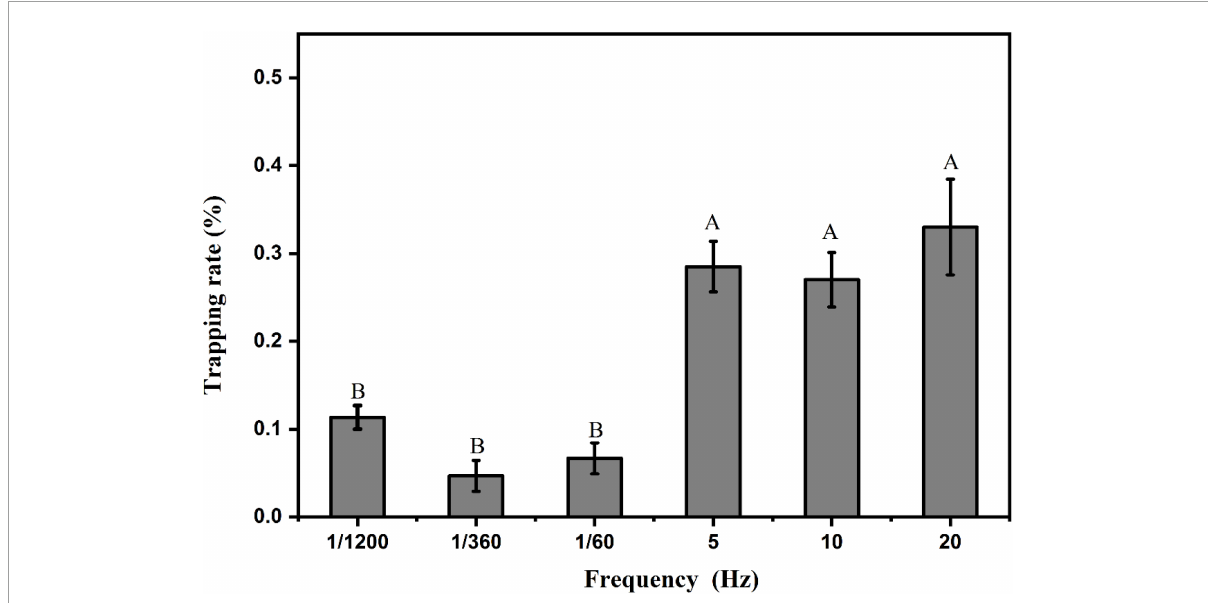
FIGURE12 Phototaxis response rates of L. striatellus at different flickering frequencies. Each value represents the trapping rate T 1 of the adult L. striatellus for that flash frequency of the light source. The error bars represent the standard errors. Different letters above each group of data indicate significant differences between treatments ( p < 0.01).